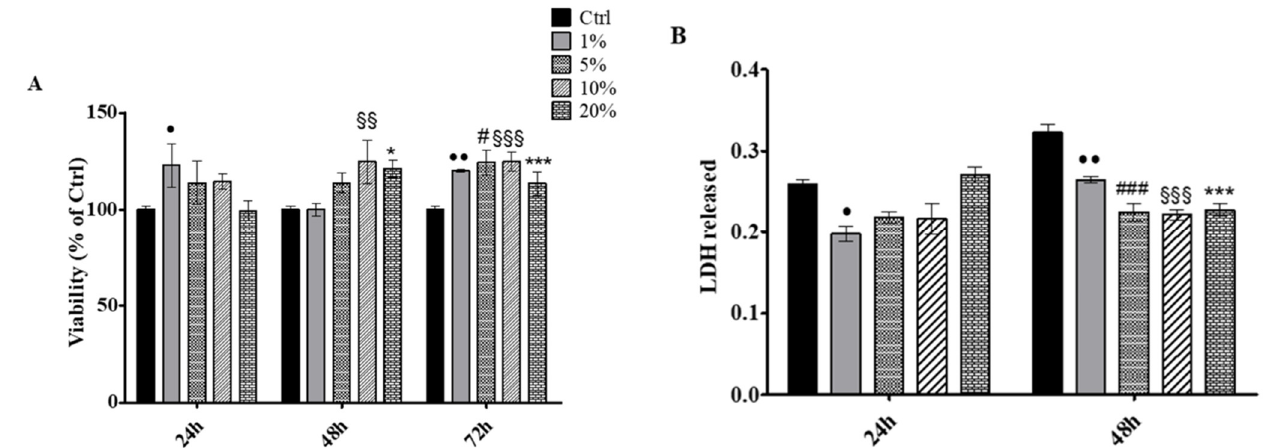
Figure 7. ( A ) MTT assay performed on Hacat keratinocytes treated for 24 h, 48 h and 72 h with SWLs in percentages ranging from 1 to 20%. Metabolic activity was normalized to control cells treated with DMEM culture medium. The most representative of three separate experiments is shown. Data